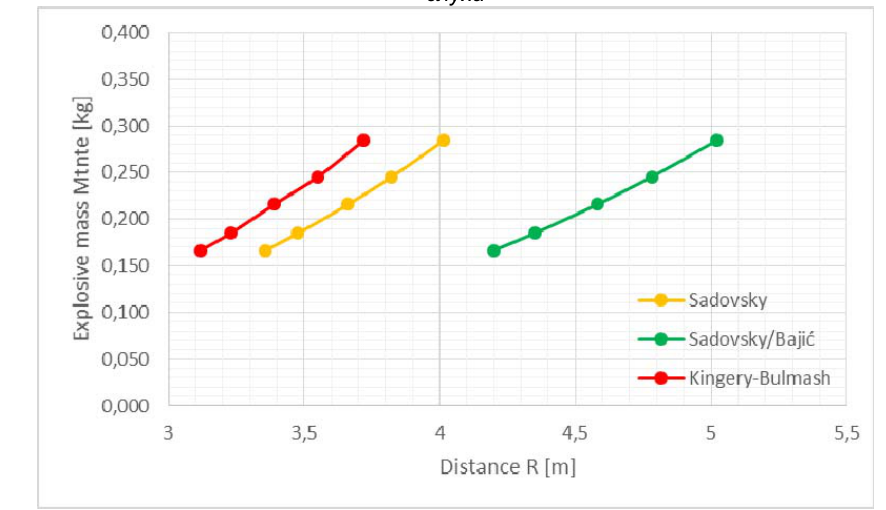
Figure 6 – Critical distance as a function of mass in the case of eardrum rupture Рис . 6 – Критическое расстояние в зависимости от массы при